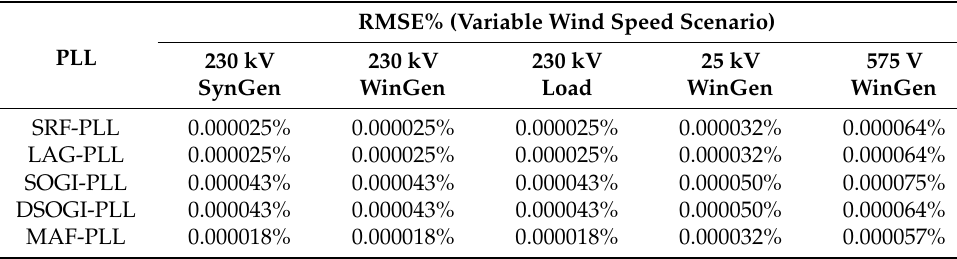
Table 7. Relative RMSE values for the PLLs located at different buses in the variable wind speed scenario.